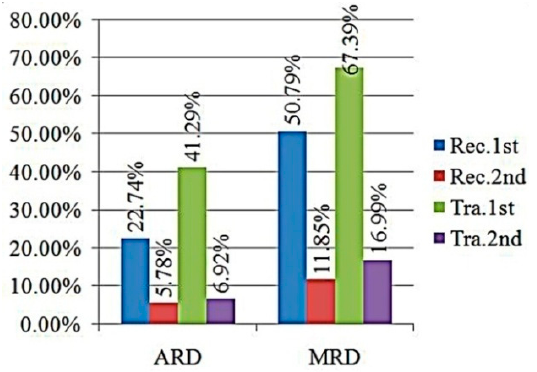
Figure 14. Deviations of viscosity values.